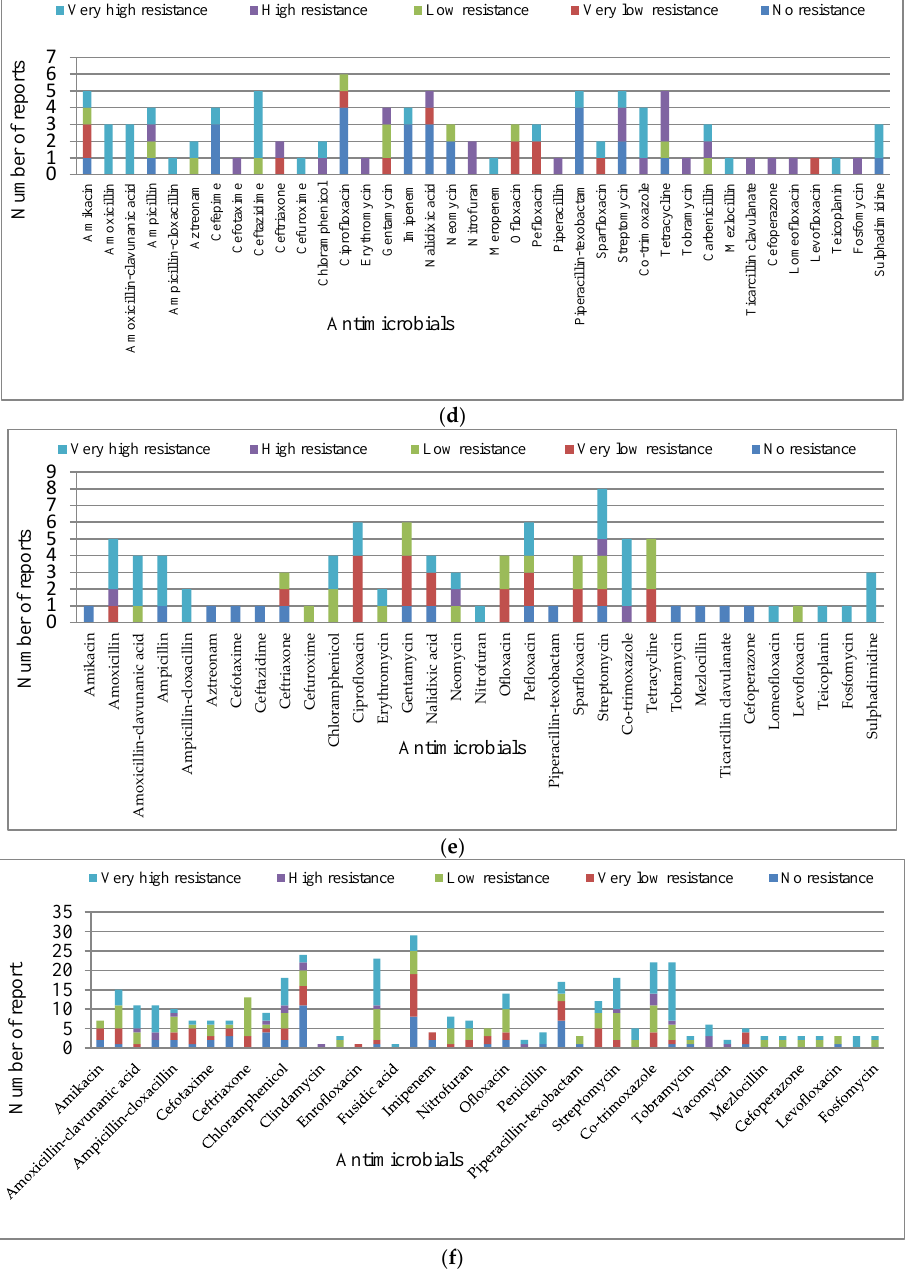
Figure 4. Number of reports of antimicrobial resistance categories for ( a ) Escherichia coli , ( b ) Salmonella , ( c ) Staphylococcus , ( d ) Pseudomonas , ( e ) Klebsiella , and ( f ) other bacteria.